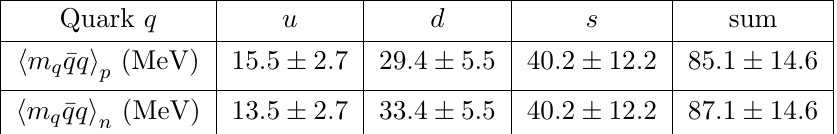
Table 6 . Nucleon matrix elements of scalar quark operators m q (cid:22) qq . Quark q